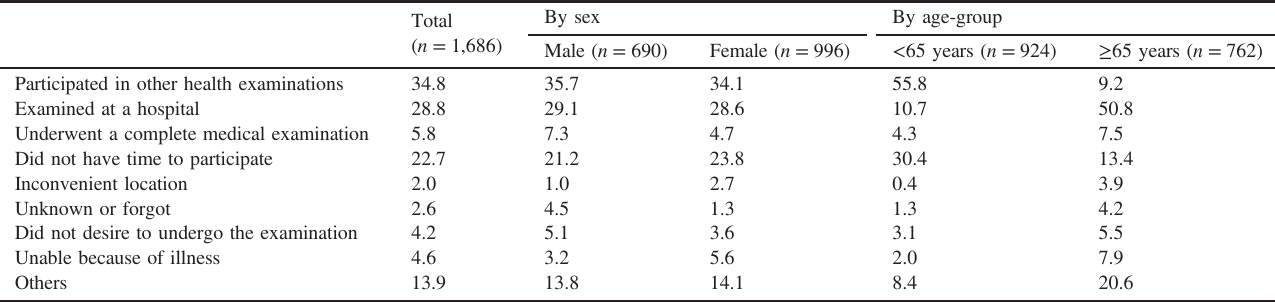
Table 2. Reasons for non-participation among participants who did not respond in the 2015 survey a ( n = 1,686)